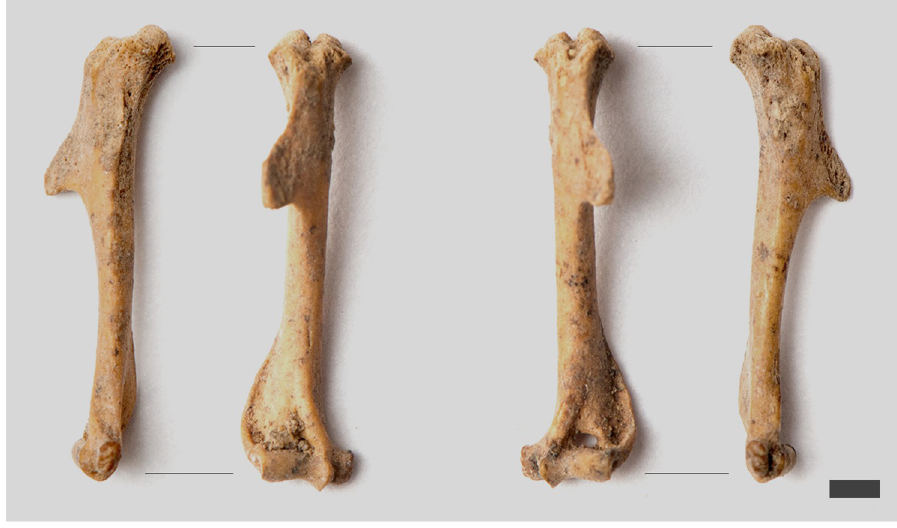
Fig 4. Identified remains of a rodent of the genus Microtus sp. in the urn from burial 853. The right and left humerus of the vole in the anterior and medial